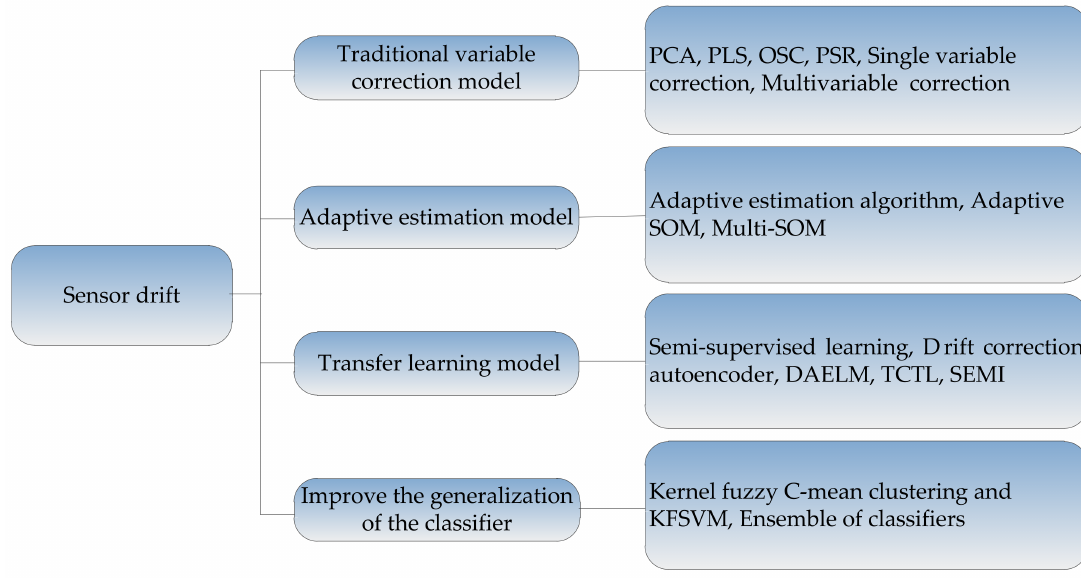
Figure 7. Methods for suppressing drift of